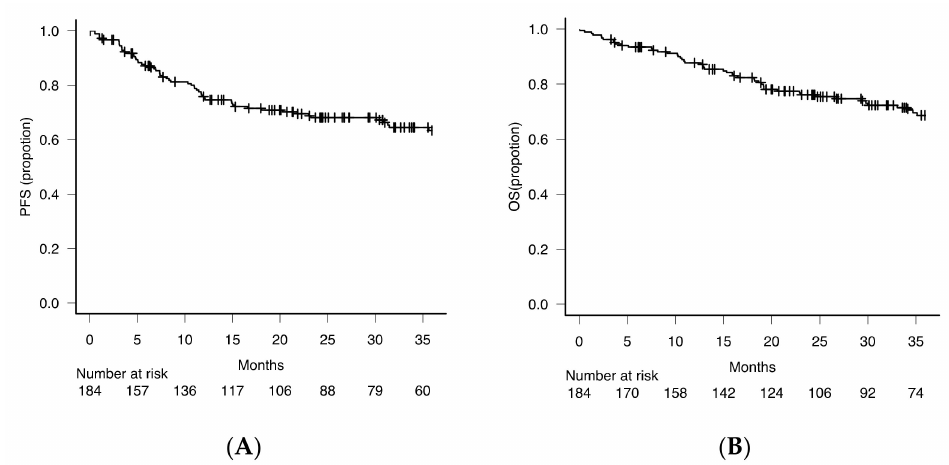
Figure 2. Survival curves. Kaplan–Meier curves for ( A ) progression-free survival (PFS) and ( B ) overall survival (OS) of 184 patients with DLBCL initially treated with R-CHOP or R-CHOP-like regimen and analyzed in this study. BM, bone marrow; DLBCL, diffuse large B cell lymphoma; OS, overall survival; PFS, progression free